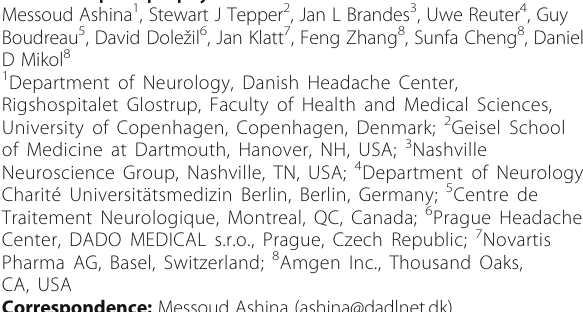
Table 1 (abstract P43). Patient-reported outcomes at Month 3 in patients with chronic migraine by baseline medication overuse status Medication overuse Without medication